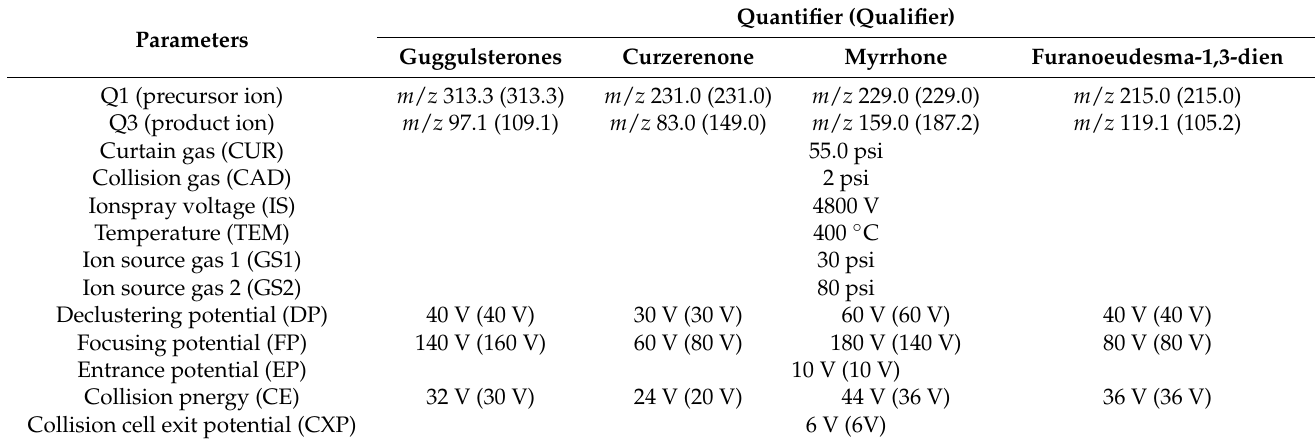
Table 7. Source and MS tune parameters for quantification of ( E )-guggulsterone, ( Z )-guggulsterone, curzerenone, myrrhone, and furanoeudesma-1,3-diene by